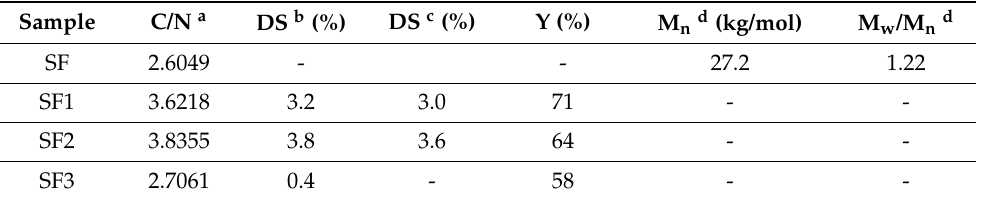
Table 1. Degree of substitution (DS %) and yield (Y %) of synthesized SF derivatives. Number average molecular weight (M n ) of raw